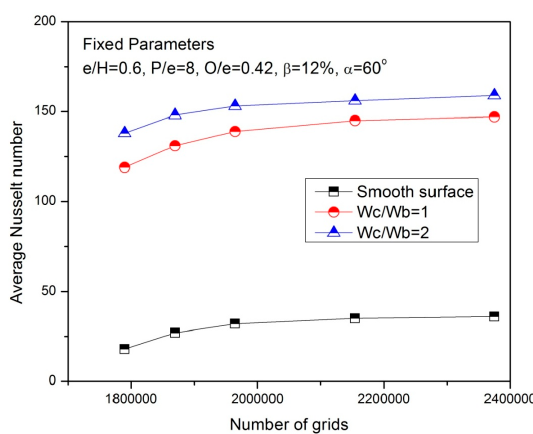
Figure 3. Schematic of the grid systems.